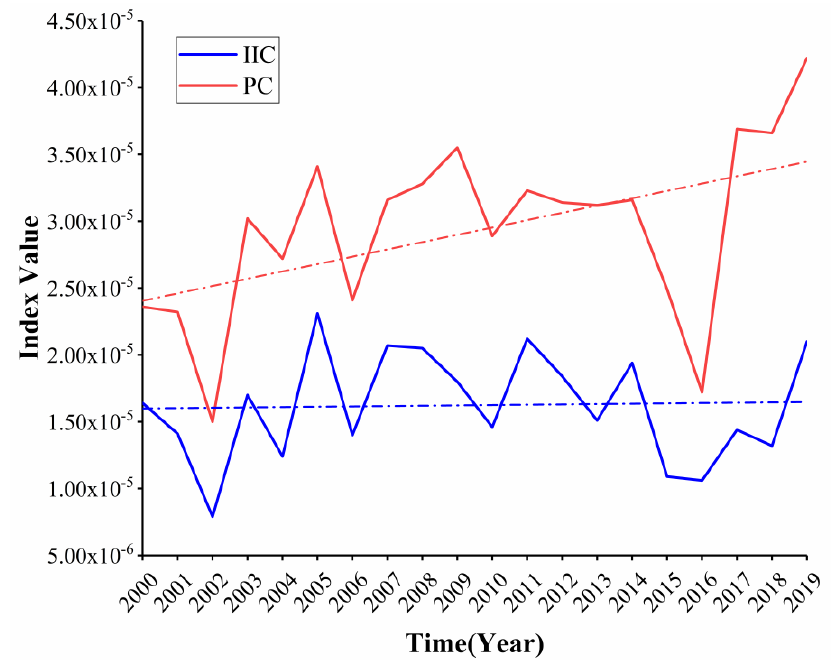
Figure 5. Changes in hydrological connectivity (IIC and PC) of Zoigê area at a distance of 300 m, from 2000 – 2019.